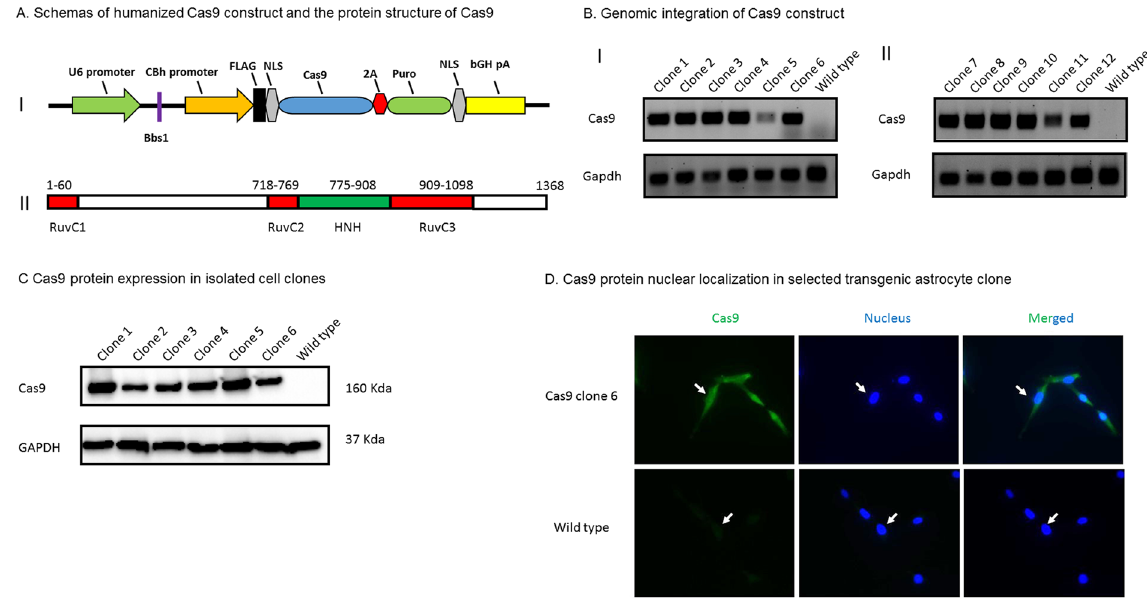
Figure 1. Establishment of stable Cas9 expression astrocytes. ( A ) Schemas of humanized Cas9 construct and the protein structure of Cas9. I: The structure of humanized Cas9 construct: The major DNA segments of humanized Cas9 construct were presented and their names were listed above. The digestion site of Bbs1 was marked between U6 promoter and CBh promoter. The construct encoded a humanized Cas9 protein with a flag tag and NLS domains and it conferred transfected cells the resistance to the antibiotic of puromycin. II: The domain structure of Cas9 protein: The major domains of Cas9 protein were presented and amino acid locations of each domain were listed above. ( B ) Genomic integration of Cas9 construct. Cas9 gene-specific primers were used to screen positive clones which contained Cas9 construct in cell genomes. Gapdh PCR products were used as a DNA extracts quality and loading control. Test results of total 12 clones were presented. ( C ) Cas9 protein expression in isolated cell clones. After the cell clone screening by PCR, protein extracts of 6 positive clones were examined with SDS-PAGE and Western blot to check protein expression of Cas9. GAPDH protein were also checked and used as a loading control. ( D ) Cas9 protein nuclear localization in selected transgenic astrocyte clone. Immunocytochemistry and fluorescence microscopy were used to determine the intracellular localization of Cas9 protein. Nucleus counterstain was used to determine the co-localization of Cas9 protein and the nucleus. The white arrows pointed to the locations of the